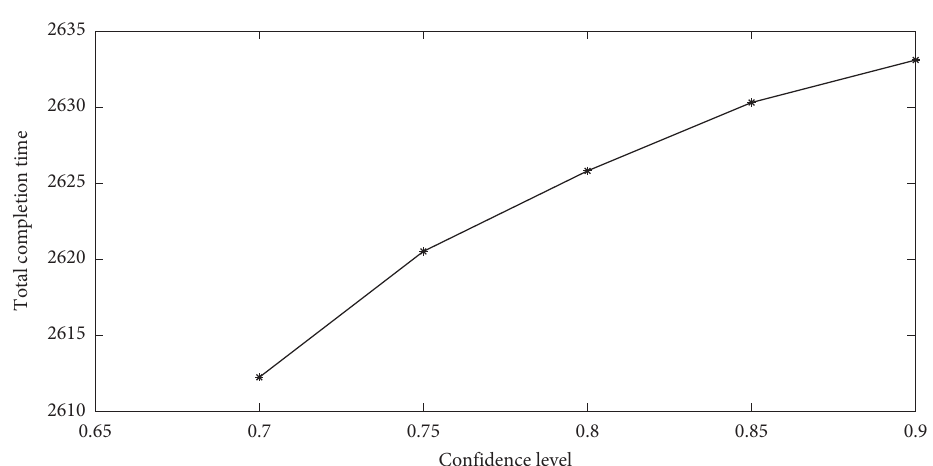
Figure 2: The sensitivity of solution for total completion time problem.